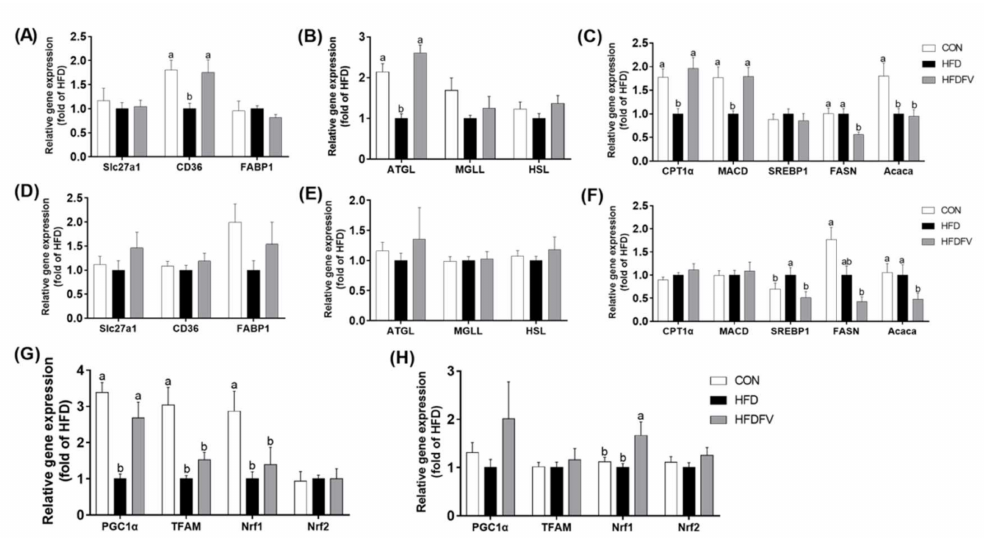
Figure 4. Effects of FV mycorrhizae on HFD-induced gene expression of lipid transport (slc27a1, CD36 and FABP1), lipases (ATGL, MGLL and HSL), β -oxidation (CPT1a and MACD), synthesis (FASN, Acaca and SREBP1) and mitochondrial biogenesis in the liver and PAT of mice. ( A ) Gene expression of lipid transport in the liver; ( B ) Gene expression of lipases in the liver; ( C ) Gene expression of β -oxidation and synthesis in the liver; ( D ) Gene expression of lipid transport in the PAT; ( E ) Gene expression of lipases in the PAT; ( F ) Gene expression of β -oxidation and synthesis in the PAT. ( G ) Gene expression of mitochondrial biogenesis in the liver; ( H ) Gene expression of mitochondrial biogenesis in the PAT. Values with different letters differ significantly (p < 0.05). Values were expressed as mean ± SEM (n =